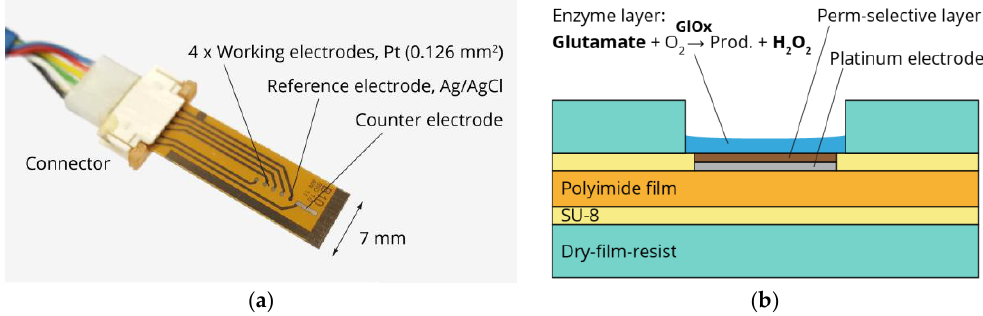
Figure 1. ( a ) Photograph of sensor platform including platinum working and counter electrodes and silver/silver chloride reference electrode; ( b ) Schematic cross-section of thin-film/laminate technology and sensor principle. Glutamate is converted by glutamate oxidase (GlOx) into hydrogen peroxide, which is oxidized at the platinum